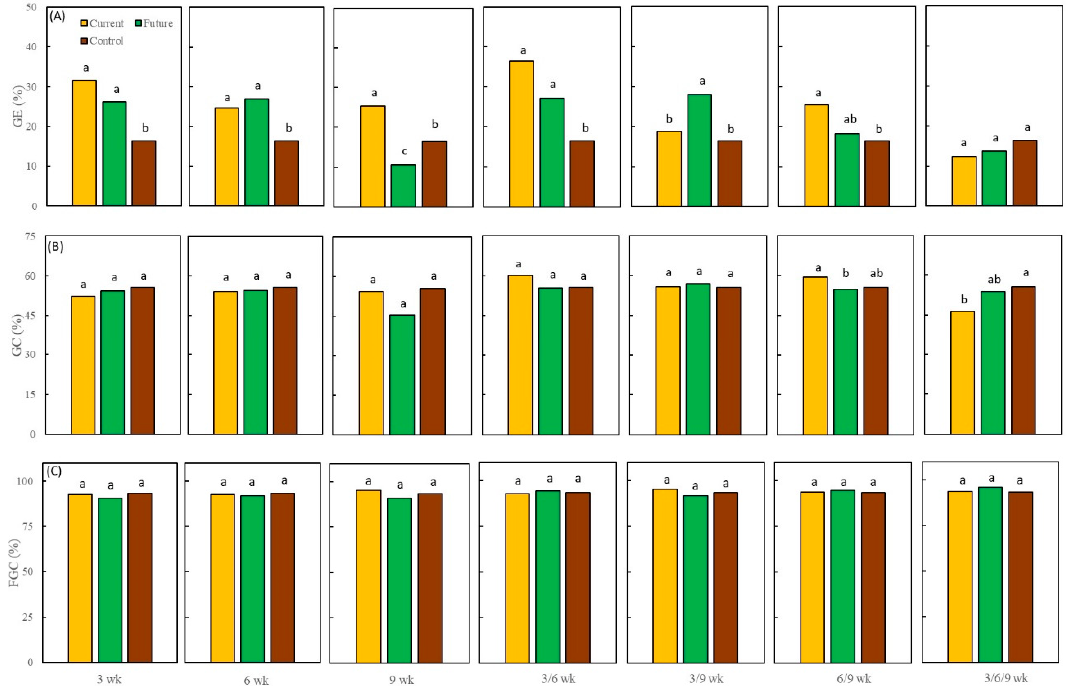
Figure 3. Effect of current (1 or 3 days at 15/10 °C) and future (25/15 °C) warm spells depends on time of interruption of cold stratification on germination energy ( A ), germination capacity ( B ) and final germination capacity ( C ) of Douglas fir seeds compared to the control (12 weeks of cold stratification without interruptions). The numbers 3, 6…3/6/9 — the week(s) when the warm spells occurred during cold stratification either singly (3, 6, 9) or in multiples (3/6, 3/9, 6/9, 3/6/9). Means with the same letter are not significantly different at p ≤ 0.05.